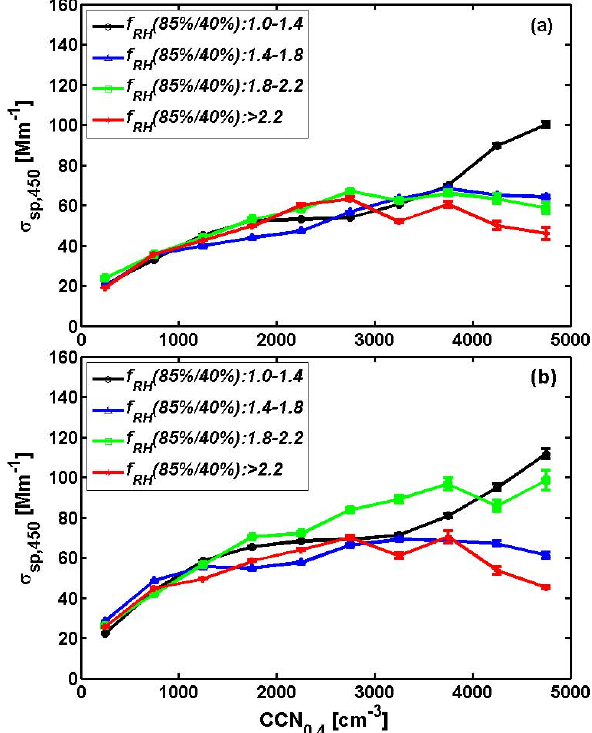
Fig. 5. Relationship between CCN 0 . 4 concentrations and aerosol scattering coefficients at 450nm for dry aerosol particles with (a) D P ≤ 1µm and (b) D P ≤ 10µm for different ranges of aerosol hy- groscopic growth factor. Data are from the SGP